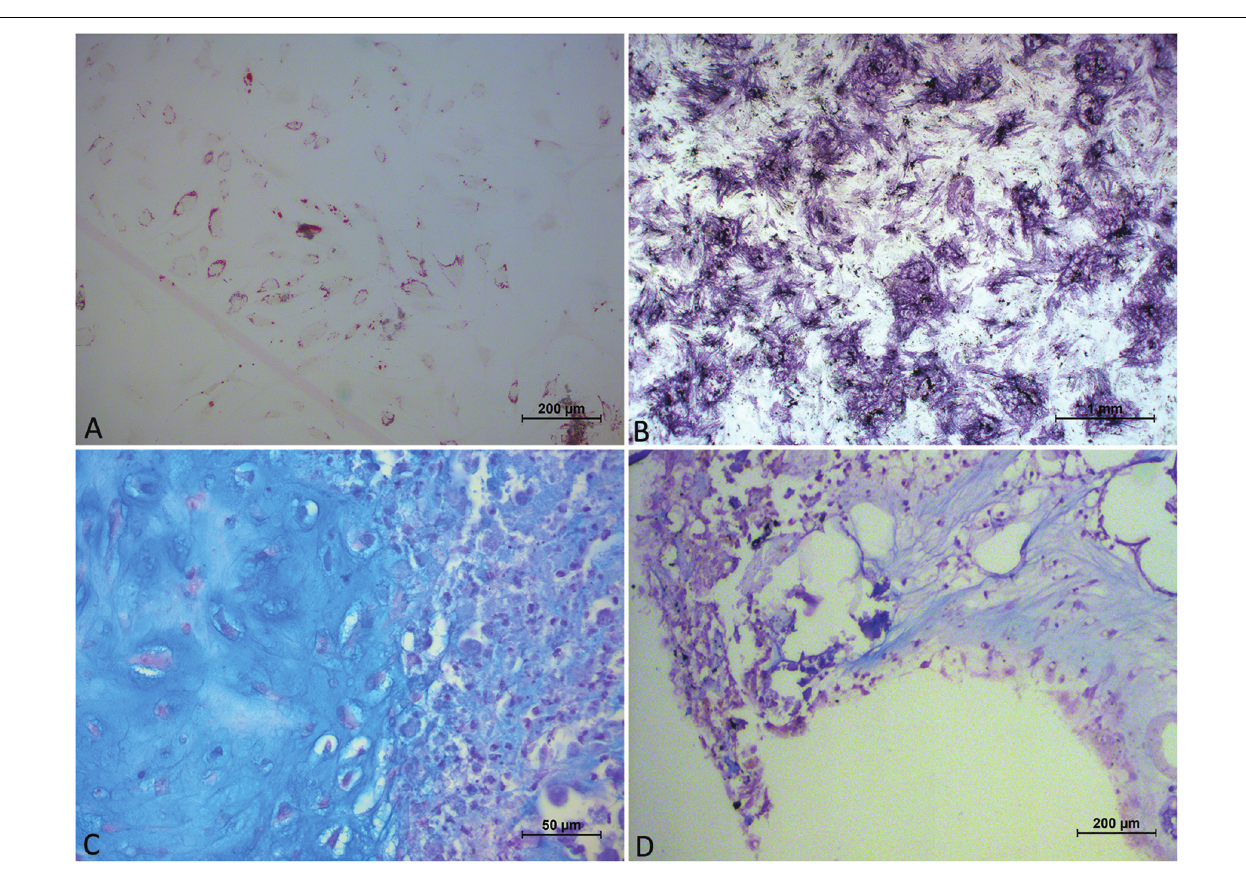
Frontiers in Cell and Developmental Biology |